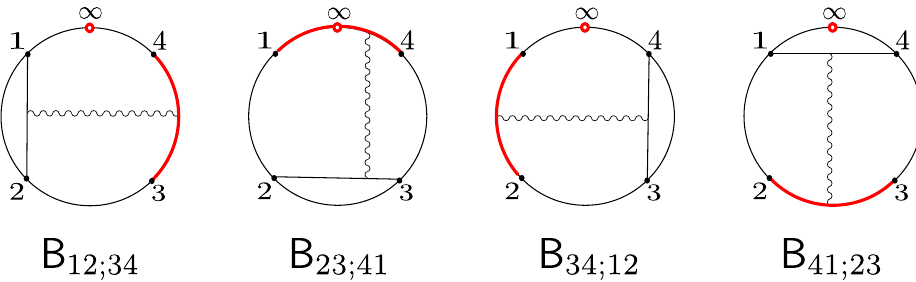
Figure 5 . Boundary diagrams relevant for the four-point functions: the wavy line denotes the gluon propagator and the red curve denotes the range of integration. Note that, although the Wilson loop is depicted as a circle in the (cid:12)gure, the computation was done for the straight-line Wilson loop. In order to keep in mind this point, we depicted a point at in(cid:12)nity in the (cid:12)gures and denoted it by the red